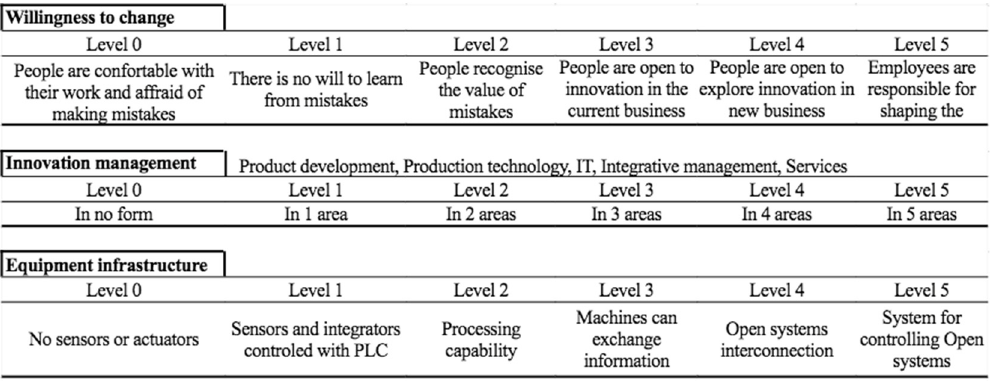
Figure 4. Three examples of sub-dimensions and respective answers (that correspond to maturity level).